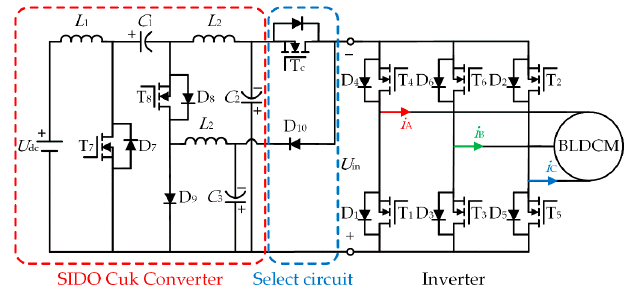
Figure 1. The BLDCM system driven by the SIDO Cuk converter.